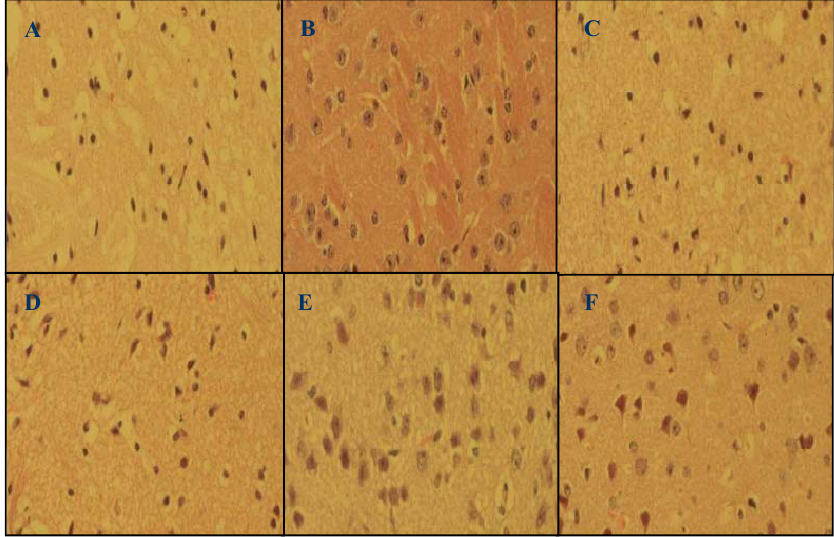
Figure 3. Protein carbonyl content estimated after 22 h of reperfusion.